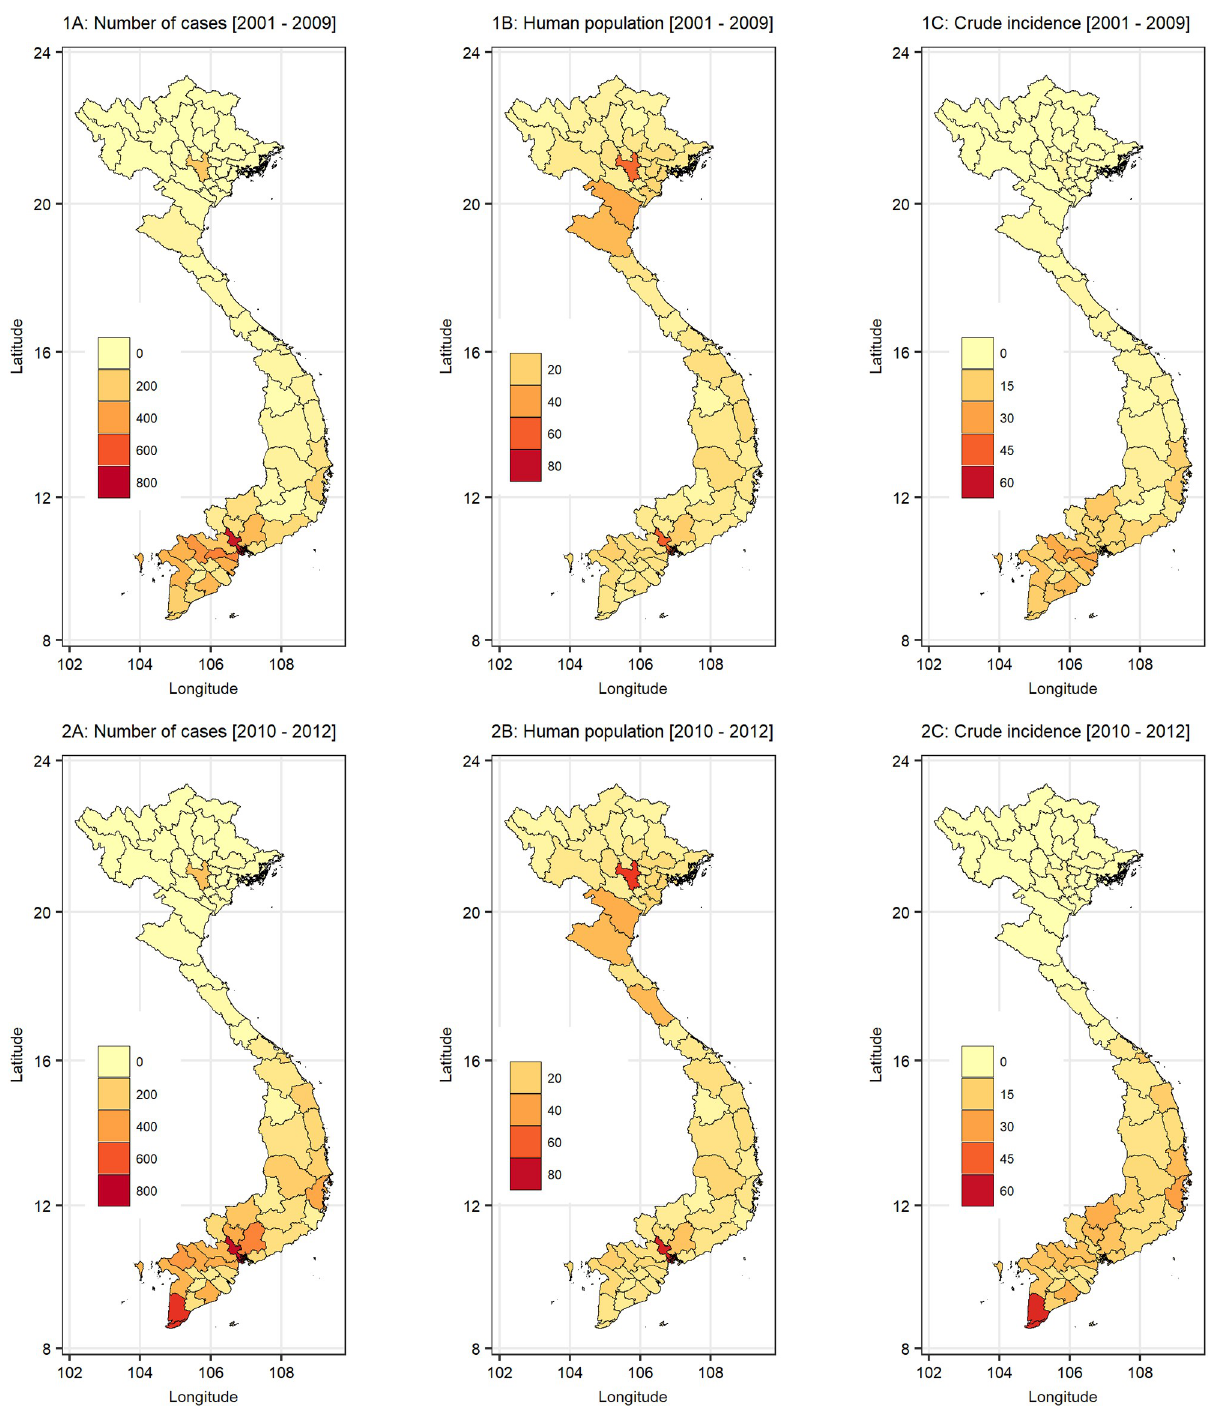
Fig 2. The distribution of crude number of dengue cases (1A), estimated human population (1B) and crude incidence (1C) by province in Vietnam in 2001–2009. The lower panel gives crude number of cases (2A), estimated human population (2B) and crude incidence (2C) by province in 2010–2012. The observed dengue incidence given in 2C was used to validate the forecasting model developed in this study.